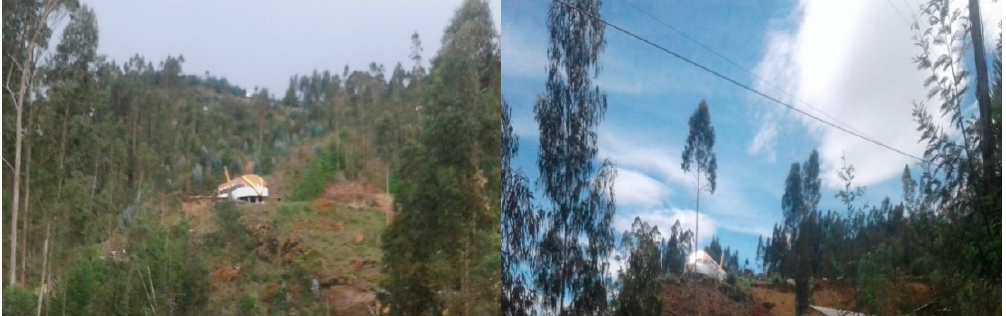
Figure 26. General views of the environment regarding organic construction.